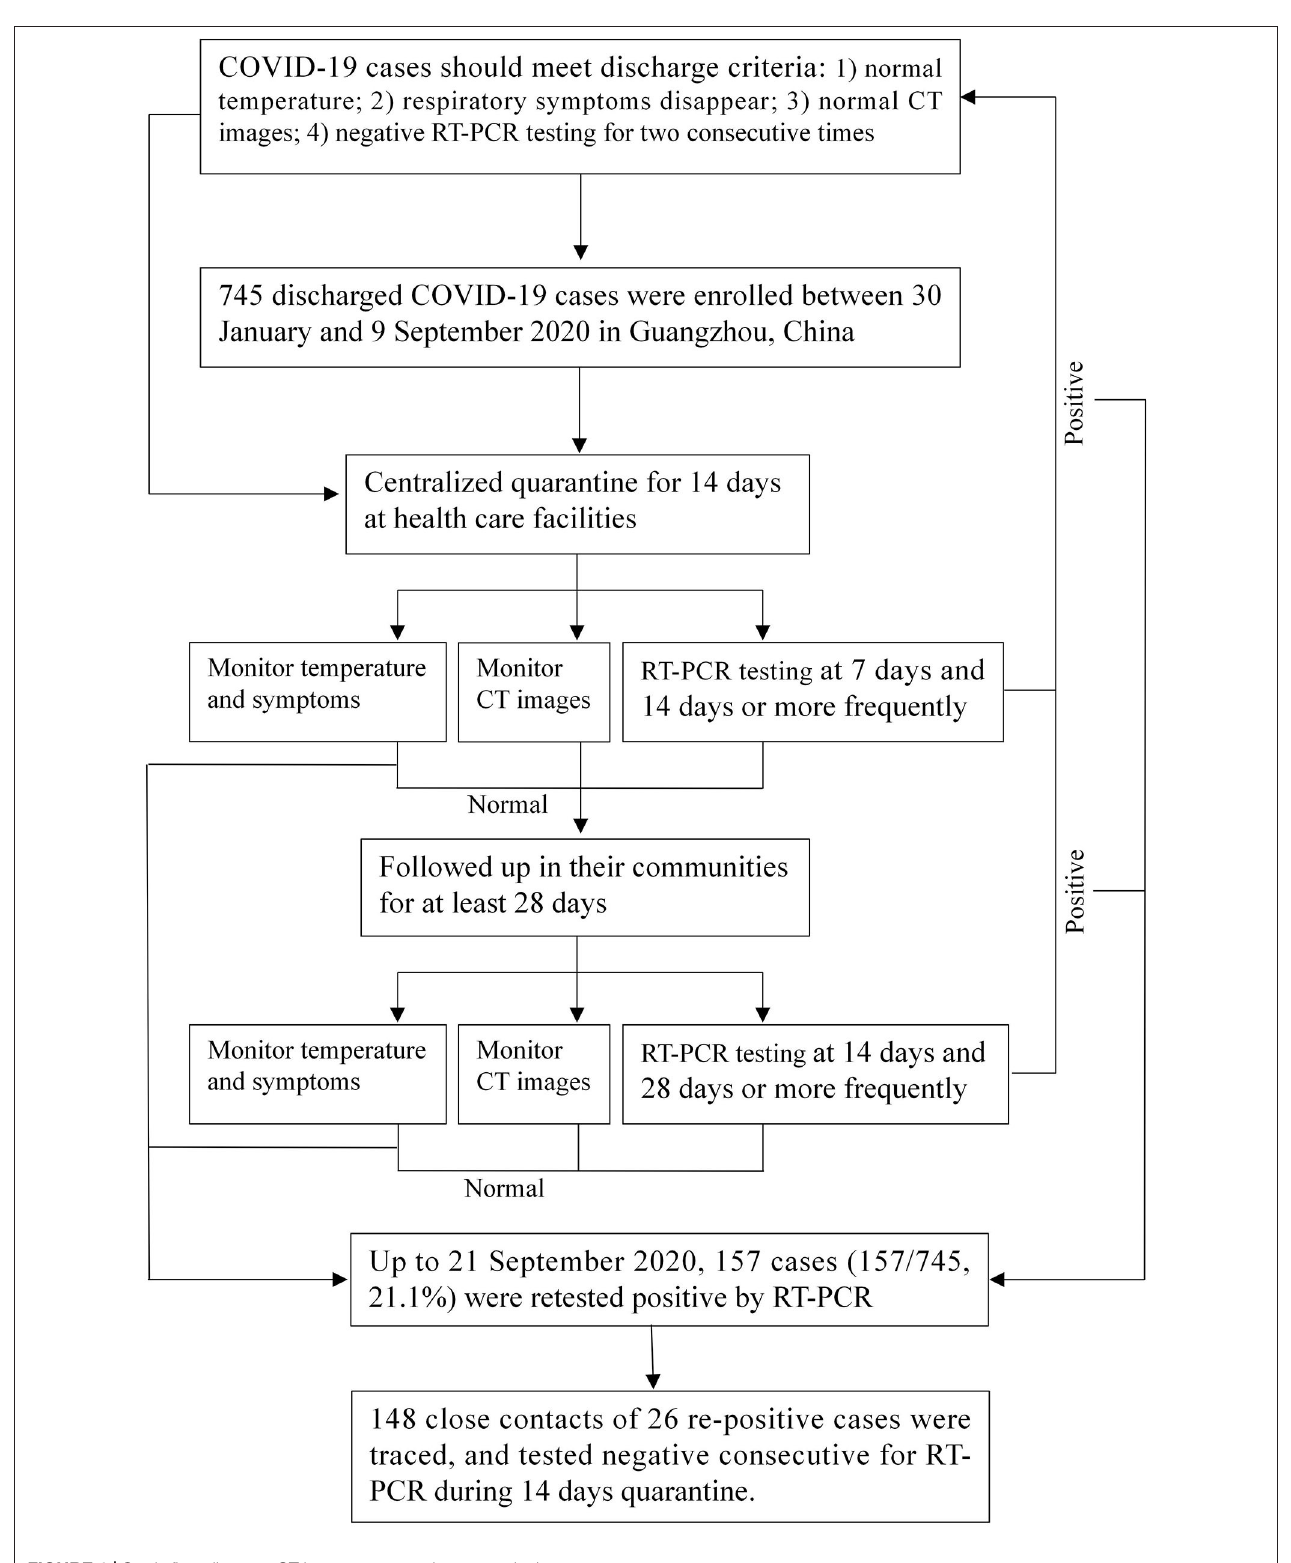
FIGURE 1 | Study flow diagram. CT image, computed tomography image.